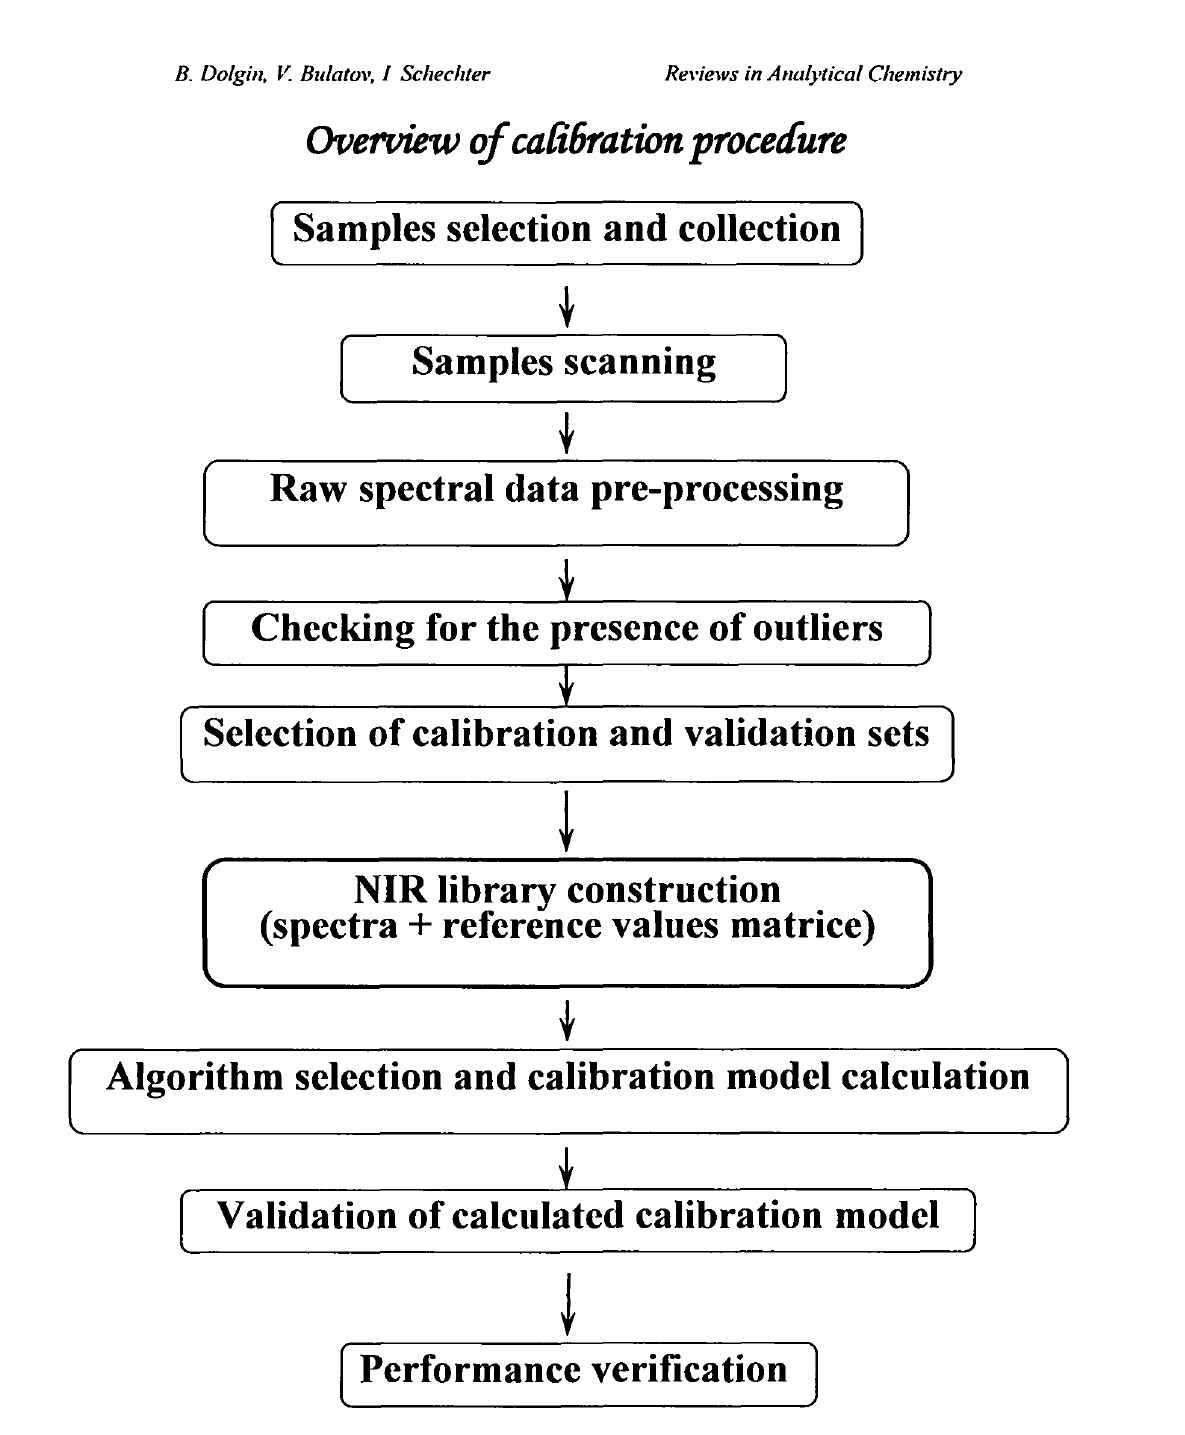
Fig. 82: Overview of calibration